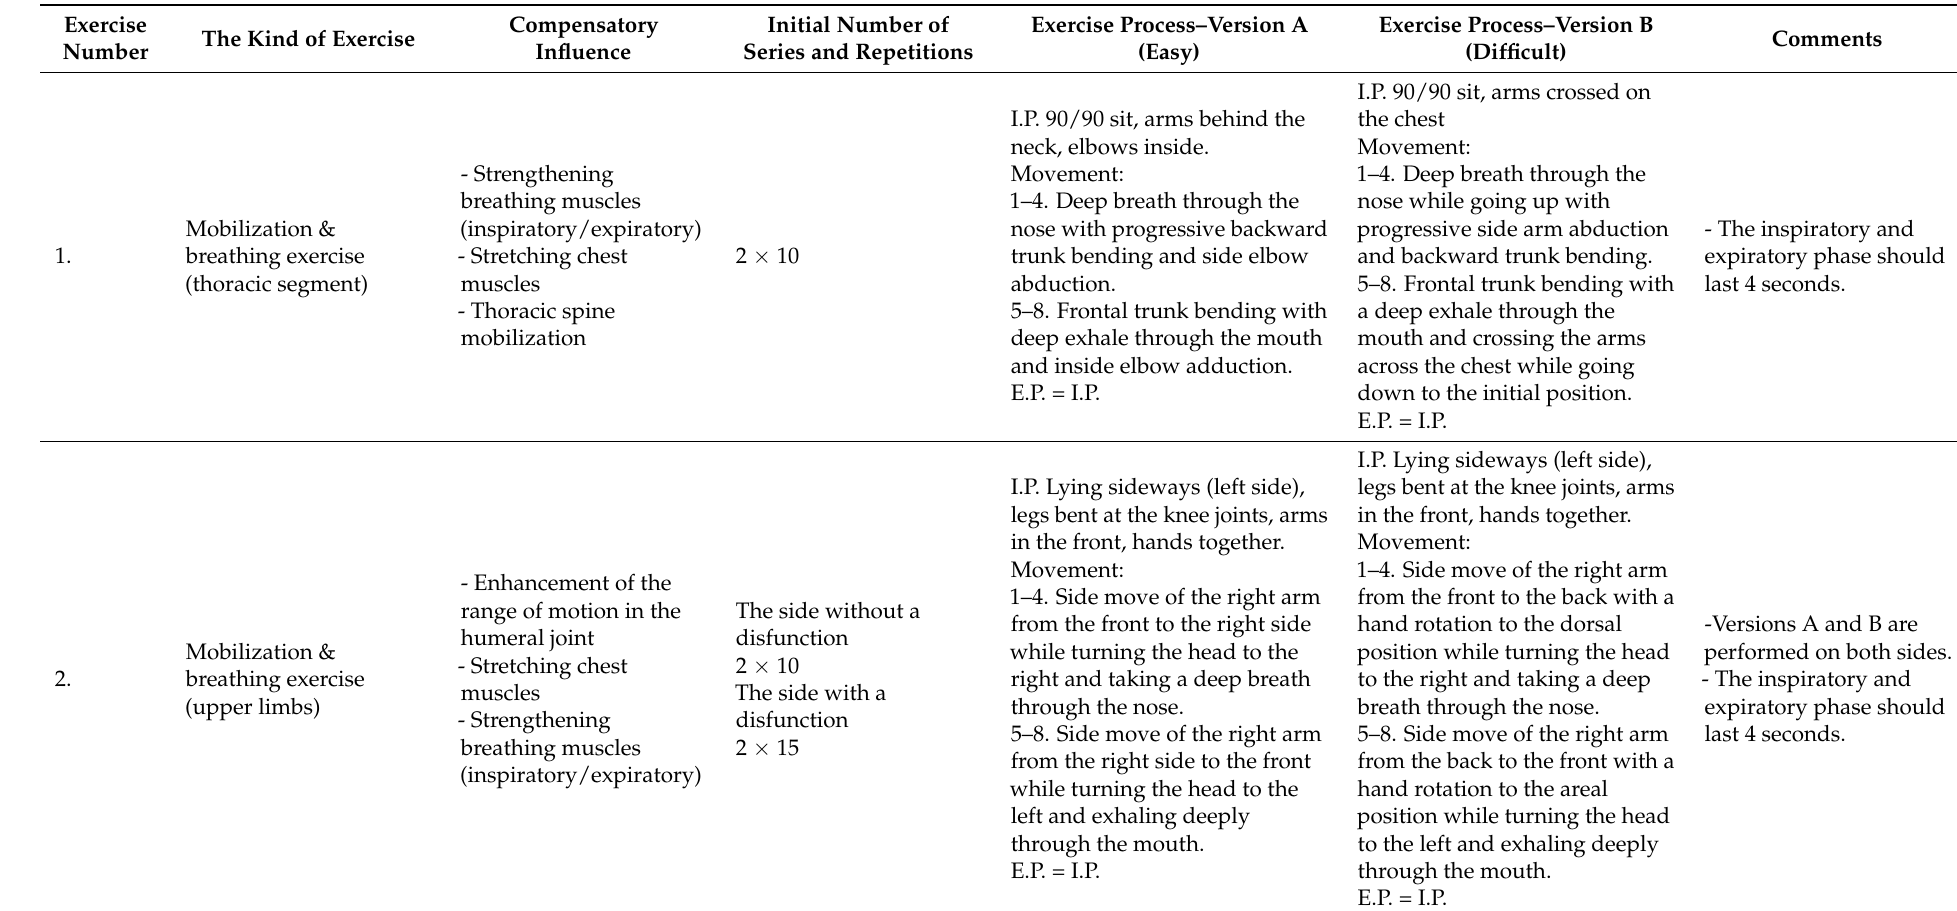
Table A1. Adapted training program with compensatory, proprioceptive exercises for sitting volleyball